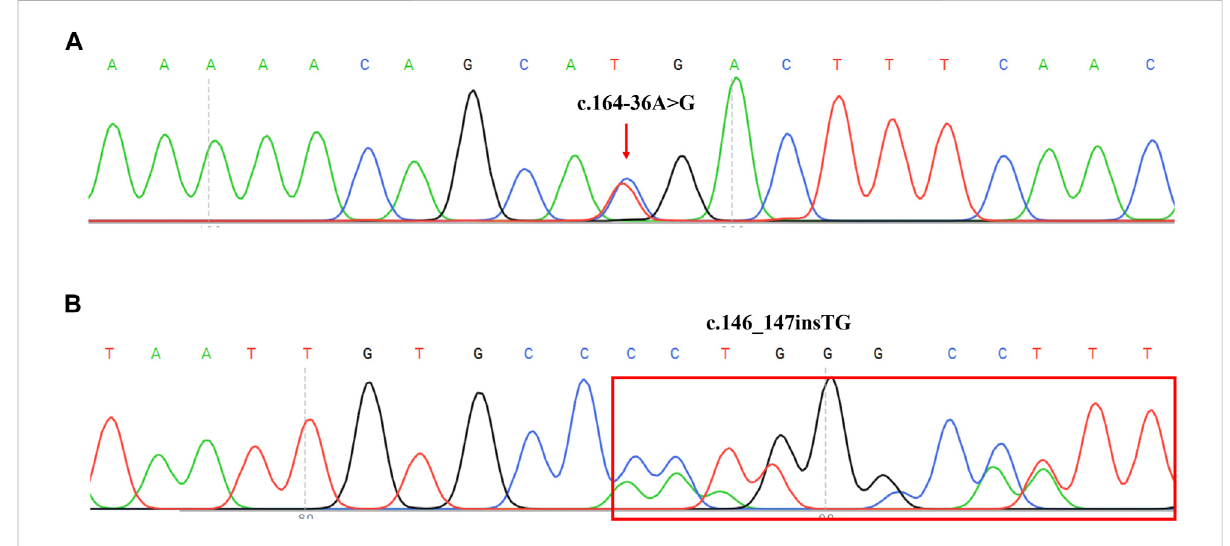
FIGURE 3 Sequencing results of two novel mutation on PTS reverse sequences in two PTPSD probands. (A) Sequence chromatogram indicated a A-to-G transition of nucleotide 164-36. The transcript of PTS gene (NM_000317) was chosen. (B) Sequence chromatogram indicated insertion of TG between nucleotide 146 and 147. The transcript of PTS gene (NM_000317) was